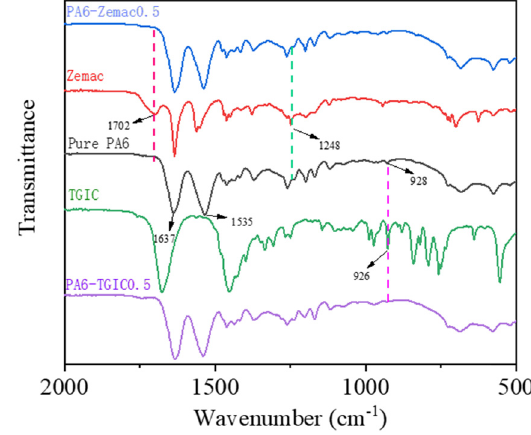
Figure 1: FTIR spectra of ZeMac, TGIC, pure PA6, PA6 - ZeMac 0.5, and PA6 - TGIC 0.5.